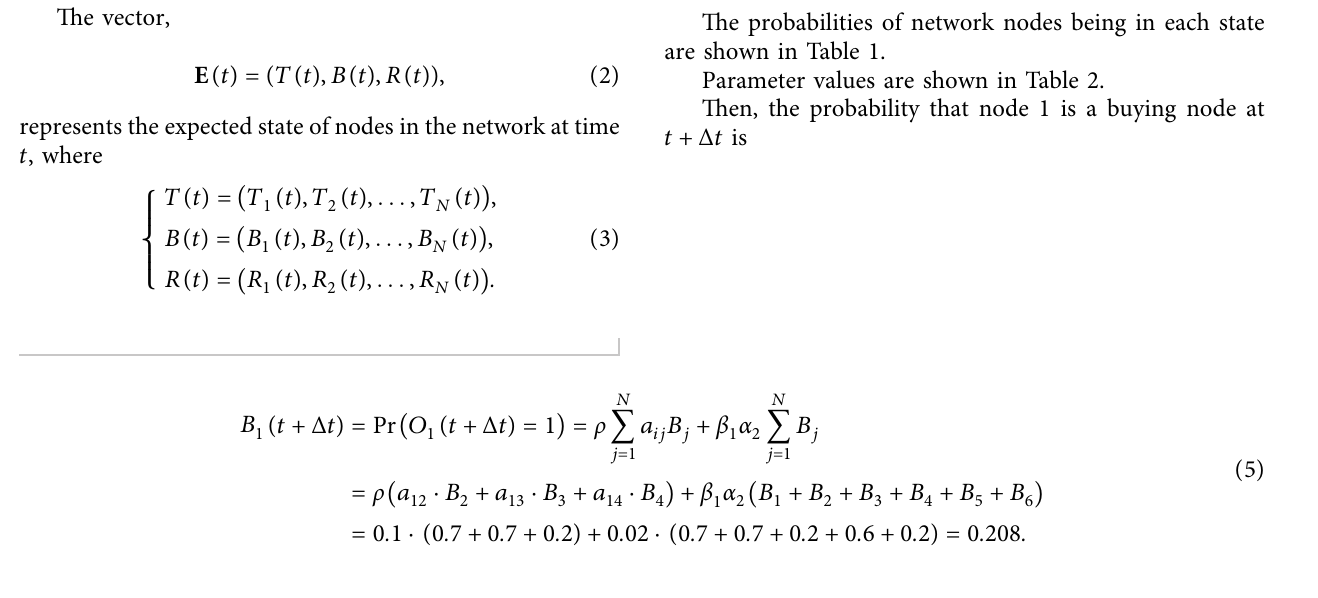
Figure 1. In practice, parameters ρ , c , α estimated from the information of the network.